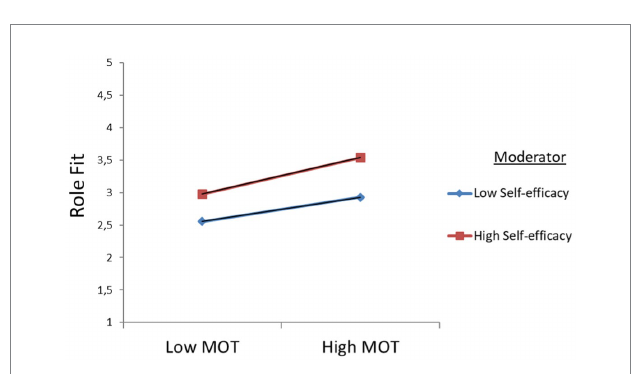
FIGURE 5 Graphical visualization of interactive effects for prosocial motivation (MOT) and self-efficacy on role fit at the beginning of military training (EMTM).